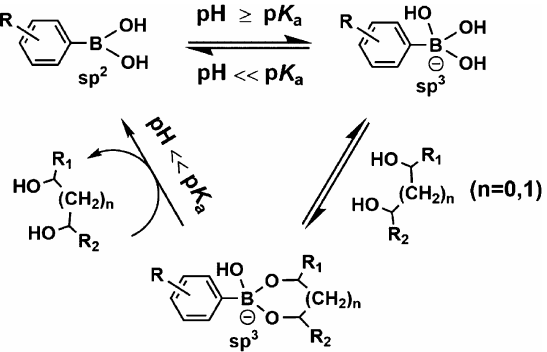
Figure 12. Reaction scheme for the complex formation of aryl boronic acids with diols. Figure taken from the reference [120].